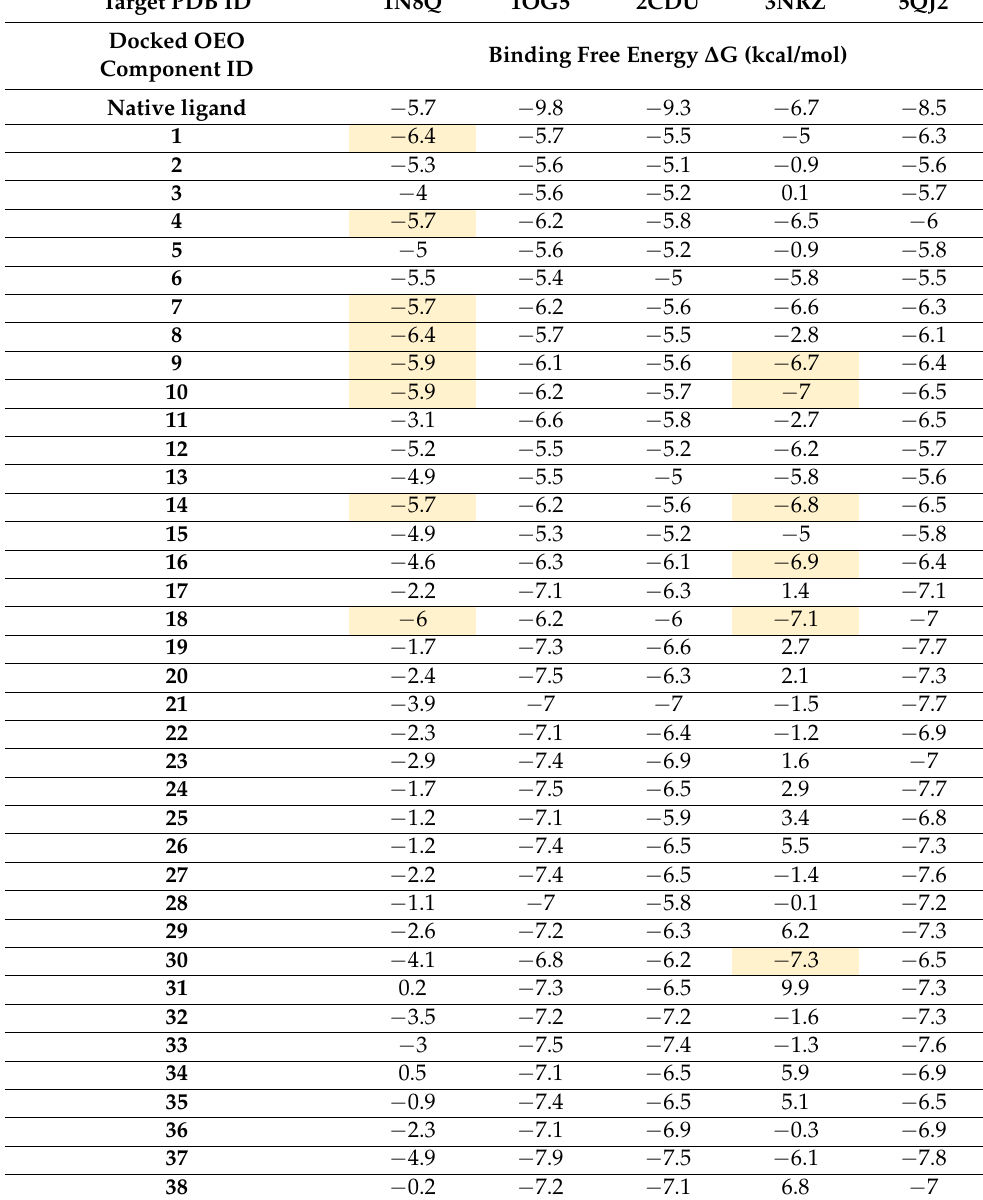
Table 4. Docking scores for compounds 1 – 38 (binding energy, kcal/mol); compounds with better docking scores than the target native ligand score is